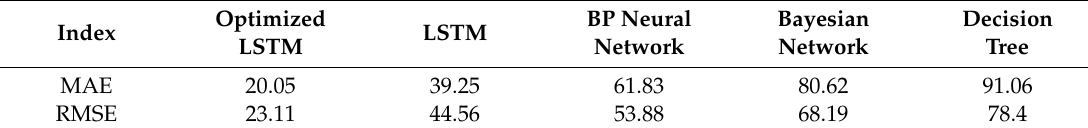
Table 5. Accuracy comparison of the PSO-LSTM model and other machine learning models.